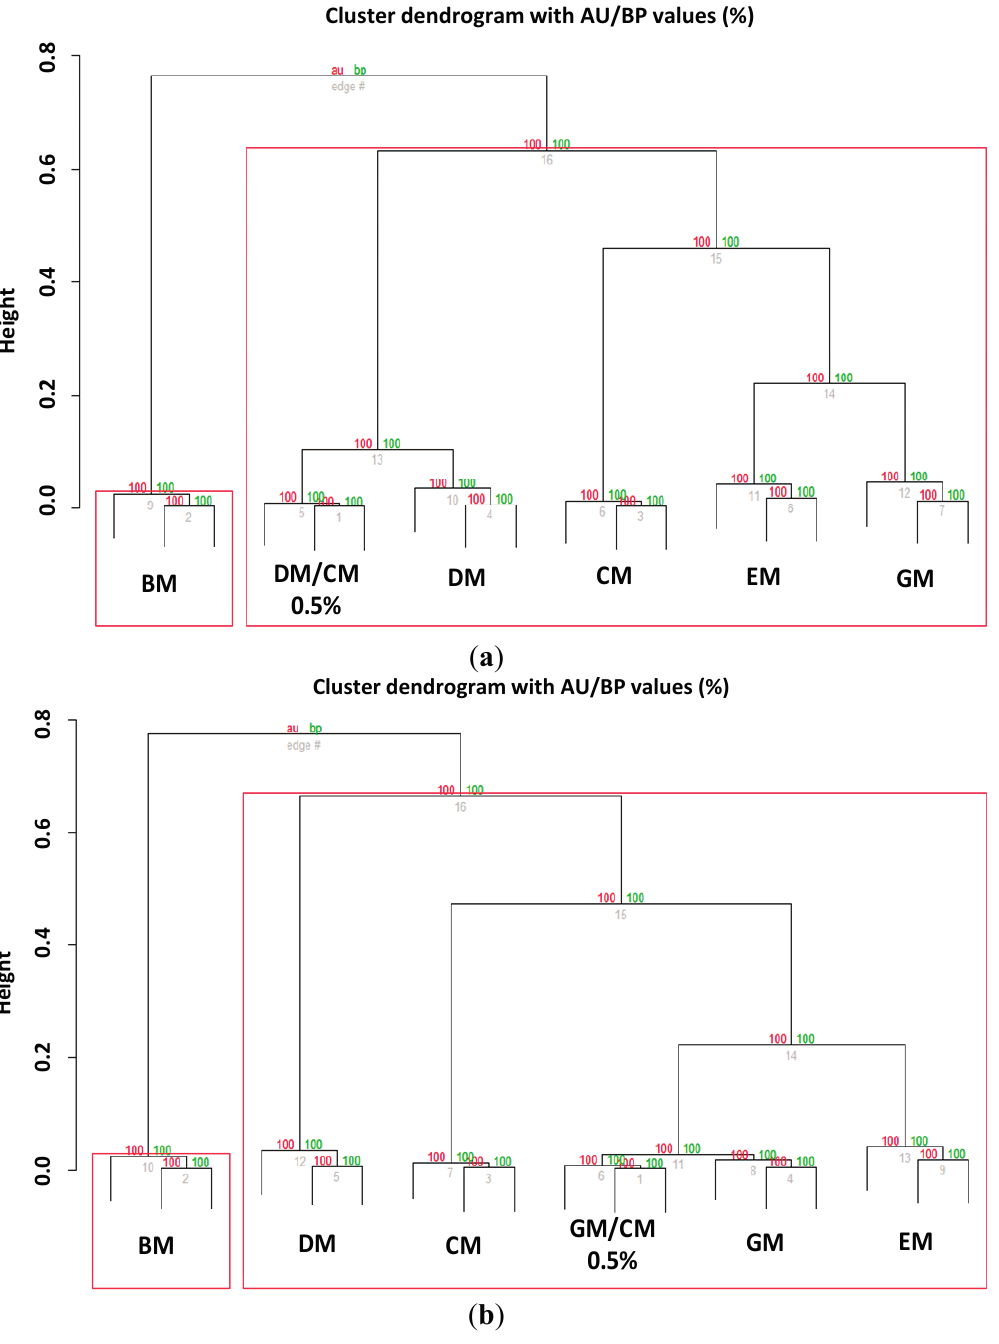
Figure 8. Bootstrapped ( n = 1000) hierarchical clustering tree of ( a ) adulterated DM and ( b ) GM with CM (0.5% adulteration) generated via pvclust. Values on the edges of the clustering are p -values (%). Red values are AU (Approximately Unbiased) p -values, and green values are BP (Bootstrap Probability) values as explained in methods section. Clusters with AU larger than 95% are highlighted by red boxes and indicate reliable